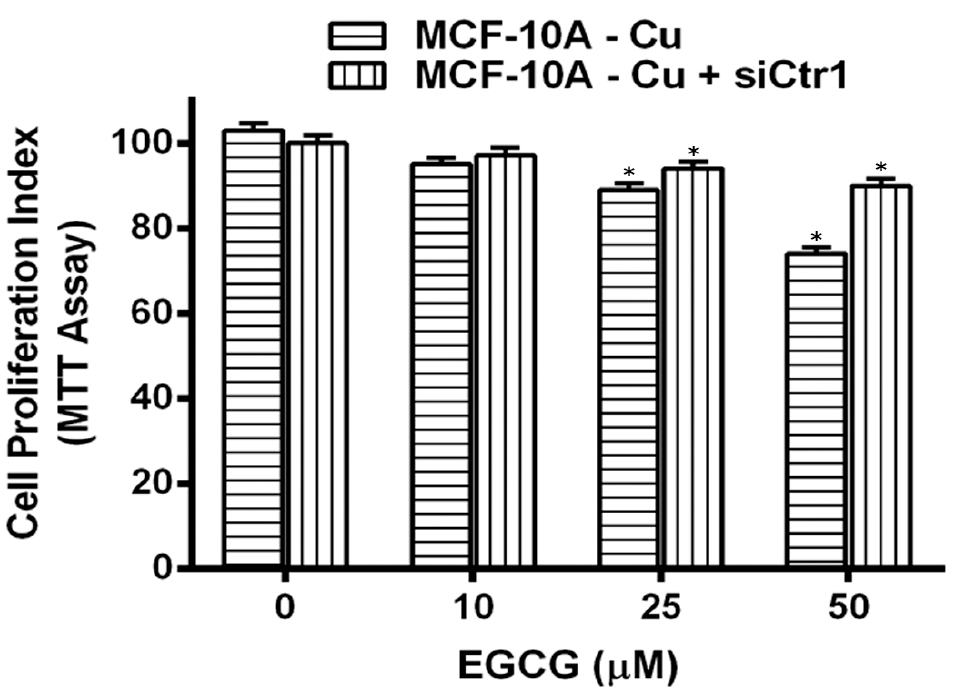
Figure 9. Elevated mRNA transcript levels of copper transporters Ctr1 and ATP7A in MCF-10A-Cu cells, relative to the parental MCF-10A cells, and the effect of EGCG. Total RNA was isolated by using TRIzol reagent (Invitrogen, Carlsbad, CA, USA) according to the manufacturer’s instructions. Real-time PCR was used to quantify Ctr1 and ATP7A mRNA expression as described in the Materials and Methods section. Only MCF-10A-Cu (normal MCF-10A cells cultured in a medium containing 25 µM CuCl 2 ), with elevated mRNA expression of copper transporters, was subjected to treatment with EGCG (50 µM) to assess the effect of EGCG on mRNA expression. Values reported are ± S.E. of three independent experiments. * p value < 0.01 when compared to respective control.